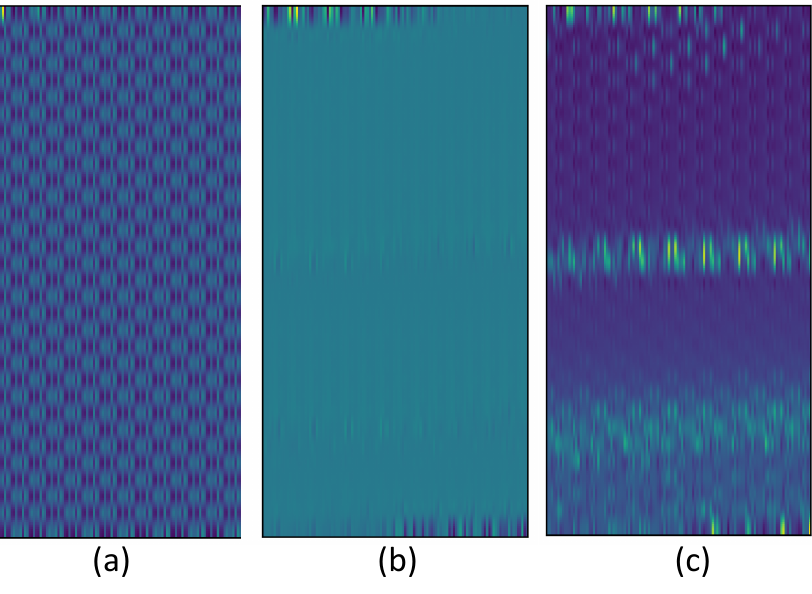
Figure 6. The feature maps of D-Glutamic acid generated with ( a ) absorption rate, ( b ) refractive index, and ( c ) 2D hybrid